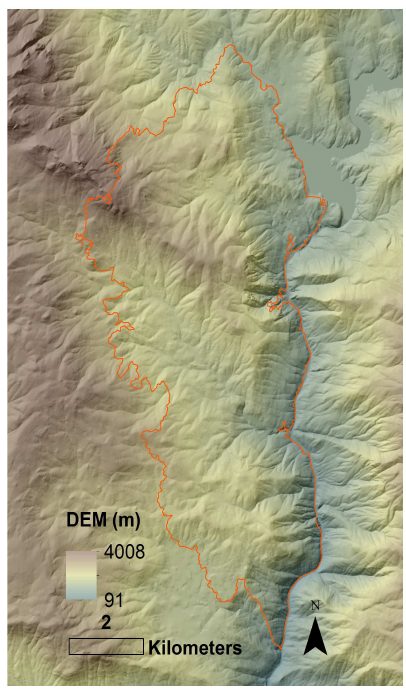
Figure 2. Example 30m DEM downloaded after the French Fire soil burn severity map was uploaded into the